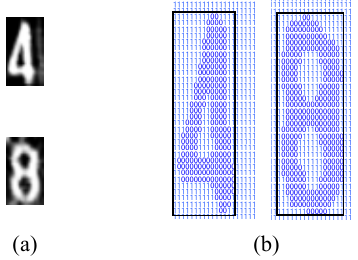
Fig. 1. Locating the character. (a) original images,